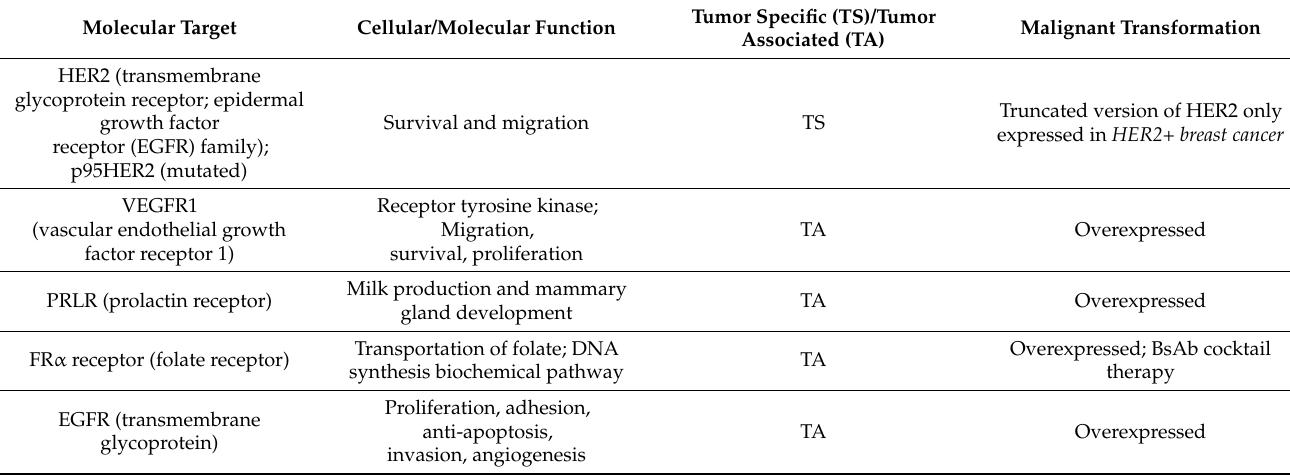
Table 2. Summary of molecular targets explored by BsAb therapy. All targets are relevant to TNBC unless specified. Molecular